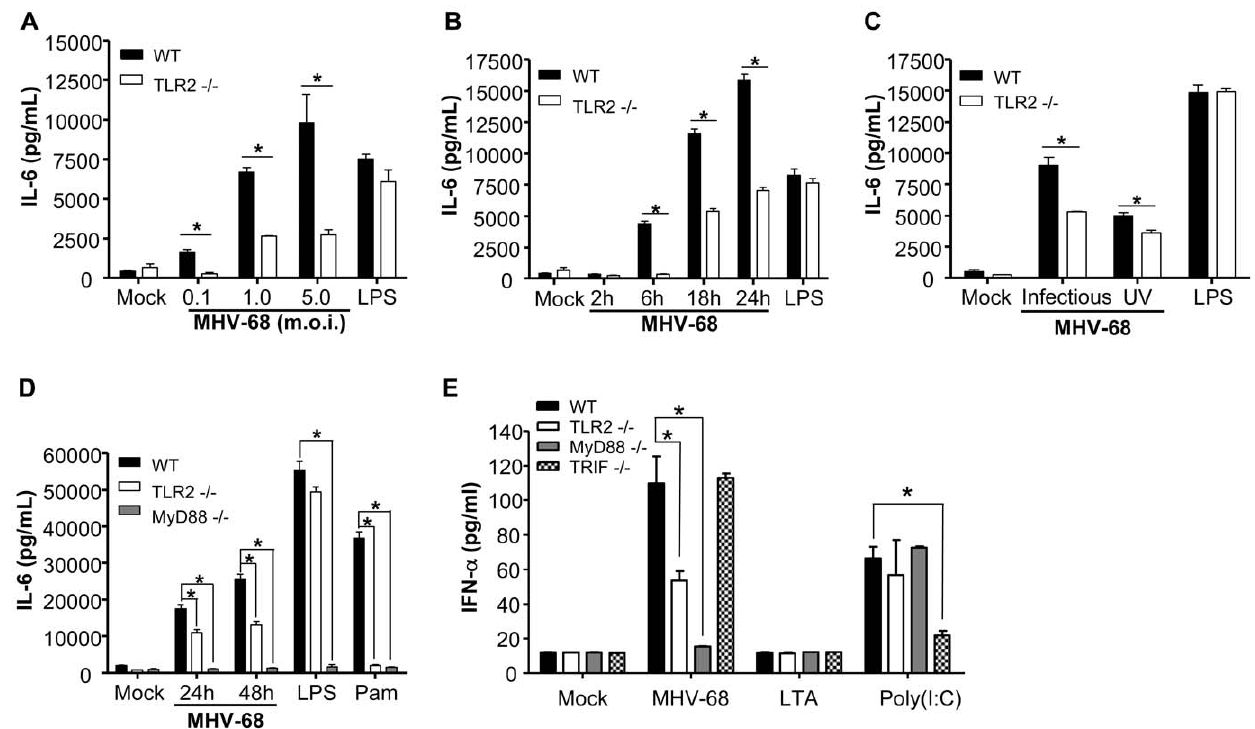
Figure 2. Inflammatory response to MHV-68 in MEFs is dependent on TLR2 expression. ( A ) WT and TLR2 2 / 2 MEFs were stimulated with mock, infectious MHV-68 at indicated m.o.i. or LPS (1 m g/ml) for 18 hours. Cell-free supernatants were then assessed for IL-6 secretion by ELISA assay. ( B ) WT and TLR2 2 / 2 MEFs were stimulated with mock or infectious MHV-68 (m.o.i. of 1) for indicated periods of time or with LPS (1 m g/ml, 18 hours). Cell-free supernatants were then assessed for IL-6 secretion. ( C ) WT and TLR2 2 / 2 MEFs were stimulated with mock, infectious MHV-68, UV-irradiated MHV-68 (m.o.i. of 1) or LPS (1 m g/ml) for 24 hours and cell-free supernatants were then assessed for IL-6 secretion. ( D ) WT, TLR2 2 / 2 and MyD88 2 / 2 MEFs were stimulated with mock or infectious MHV-68 (m.o.i. of 1) for 24 hours and 48 hours or with LPS (1 m g/ml) or Pam 3 CSK 4 (Pam, 1 m g/ml) for 48 hours and cell-free supernatants were then assessed for IL-6 secretion. ( E ) WT, TLR2 2 / 2 , MyD88 2 / 2 and TRIF 2 / 2 MEFs were stimulated with mock or with infectious MHV-68 (m.o.i. of 1), LTA (10 m g/ml) or poly(I:C) (5 m g/ml, transfected with Lipofectamine) for 24 hours. Levels of IFN- a